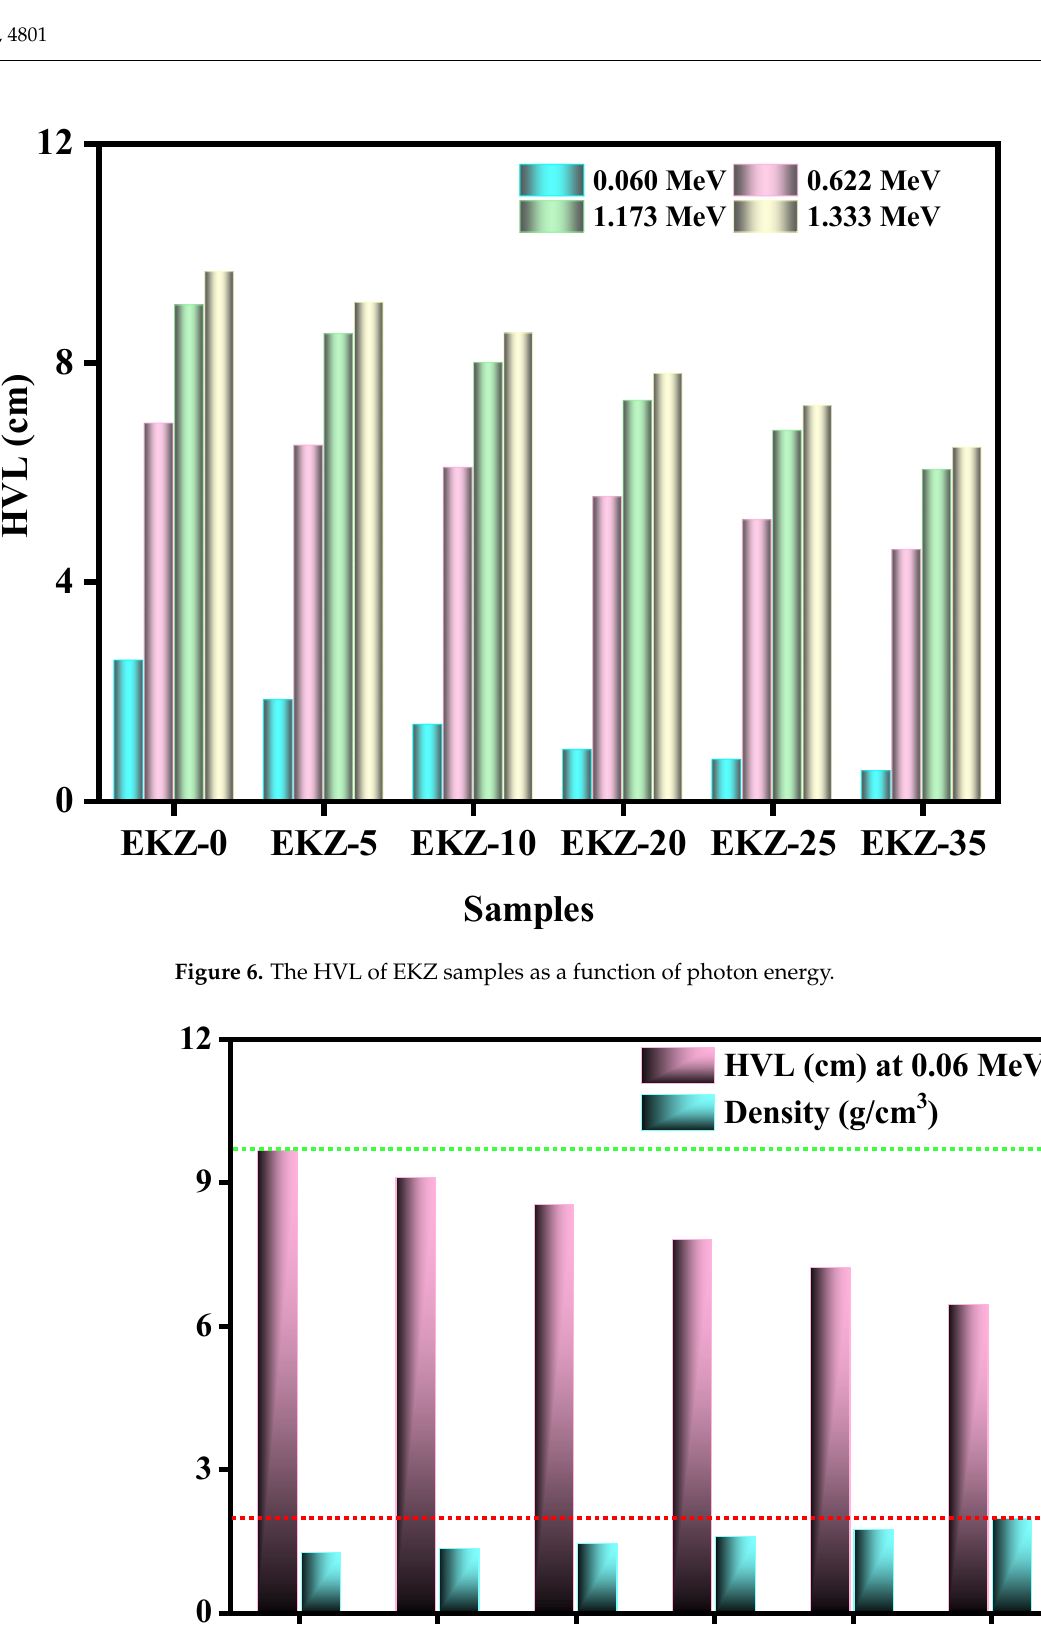
Figure 7. The variation of the HVL and the density of EKZ samples. The tenth value layer (TVL) of the six EKZ samples has been graphed in Figure 8. ergy. This is similar to the trend of HVL values; however, all the TVL values for the same samples are higher than their equivalent HVL values at the same energy. For example, at 0.060 MeV, EKZ-0 has a TVL equal to 8.5 cm, EKZ-10 has a TVL equal to 4.6 cm, and EKZ-35 has a TVL equal to 1.8 cm. Noteworthily, ZnO and HVL have shown a positively correlate with each other. EKZ-5 ′ s TVL values are equal to 6.1 cm, 21.6 cm, 28.3 cm, and 30.2 cm at energy 0.060 MeV, 0.662 MeV, 1.173 MeV, and 1.333 MeV, respectively. Thus, increasing the amount of ZnO in the EKZ samples improves the space efficiency of the material.